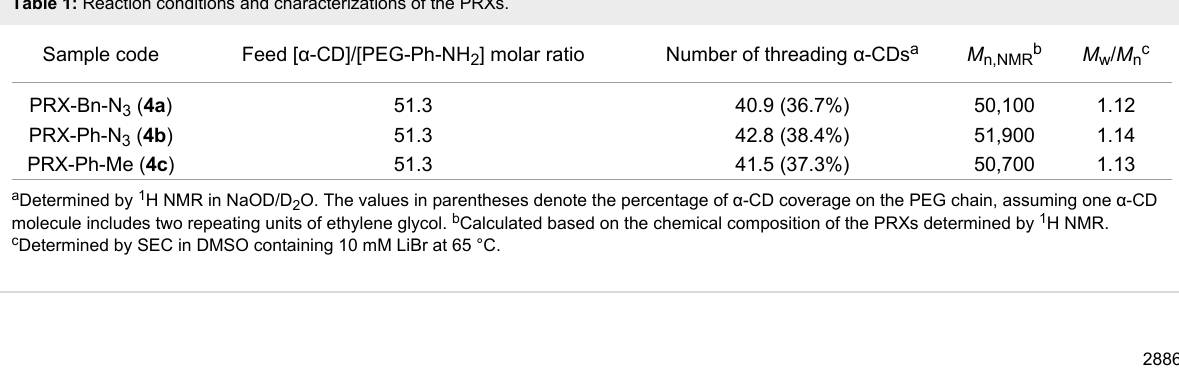
Table 1: Reaction conditions and characterizations of the PRXs.